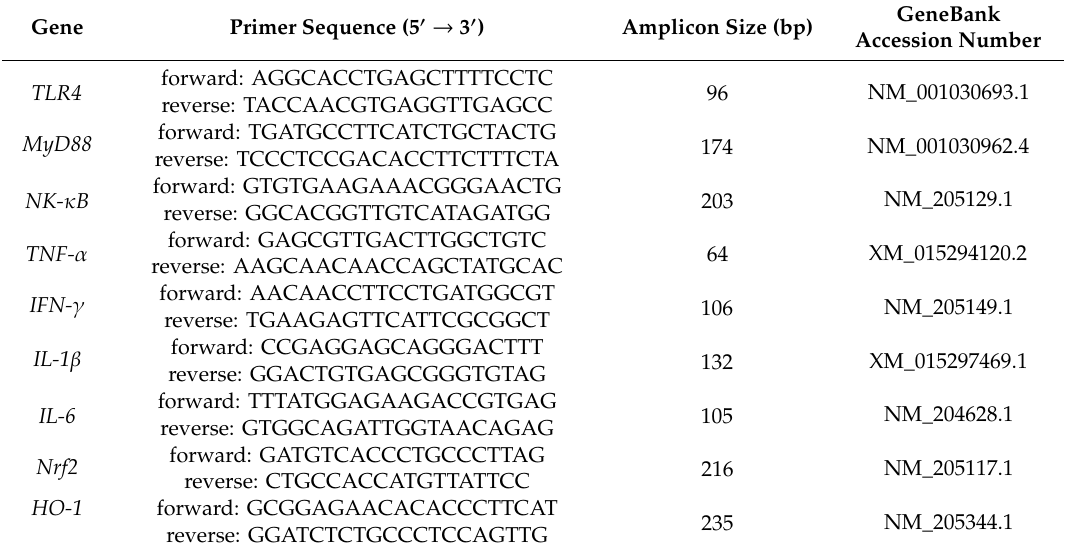
Table 2. Primer sequences used for RT-qPCR in this